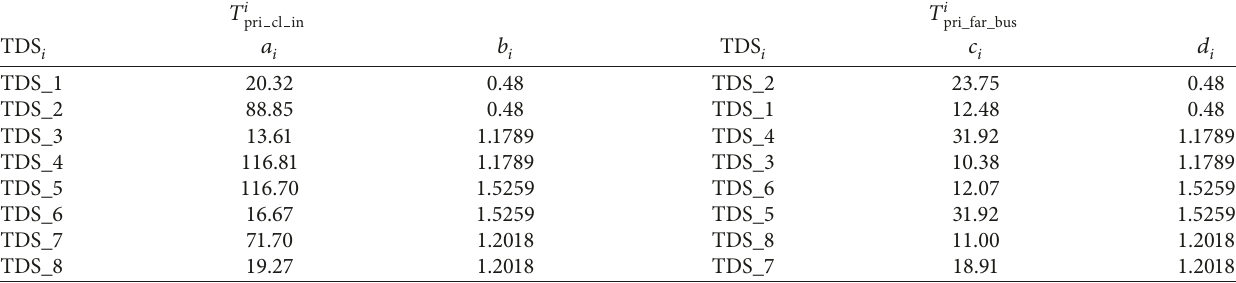
b c d i , i , i , and i for the 4-bus system [5, 9].